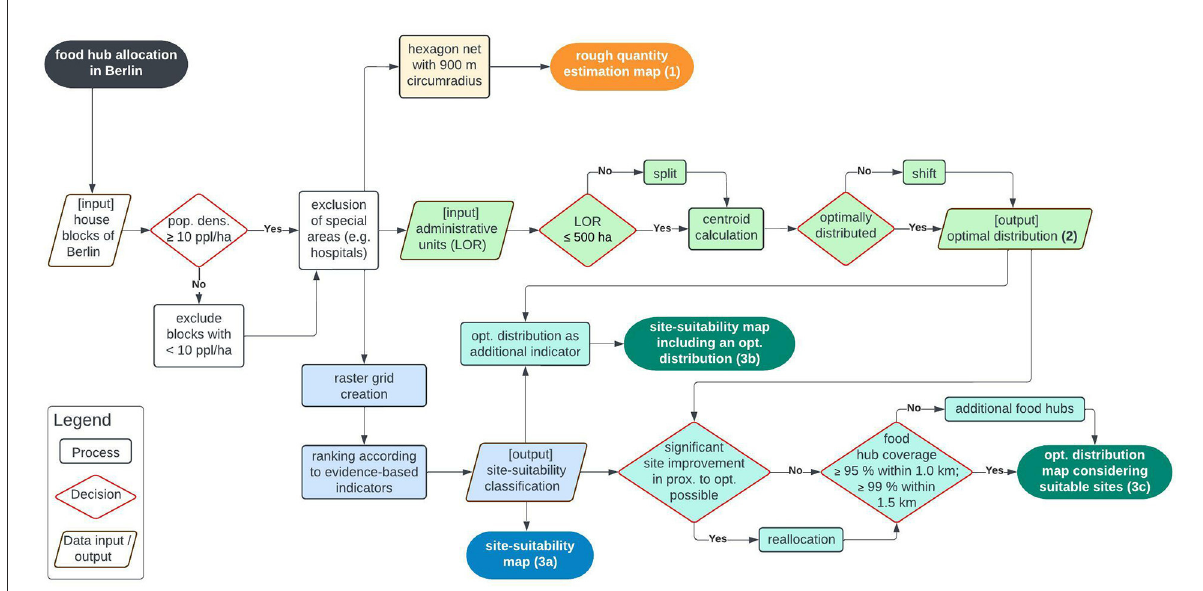
FIGURE1 Workflow and interrelationship of the different approaches. The approaches 1 and 2 aim at estimating the number of food hubs (FHs), whereas Approach 3 considers the spatial site-suitability for implementing FHs. The overall number of FHs required for Berlin was initially estimated following the 15-min city (1), an allocation to the LOR (1b) and a combination of both outcomes (2). The site-suitability for implementing FHs in Berlin considering several indicators (3a) was assessed simultaneously. The results of 2 were then combined in two different ways: the first is to integrate the distance to the locations of 2 as an additional indicator (3b), and the other is to reallocate the FHs (3c).